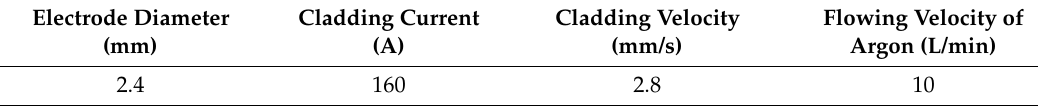
Figure 4. Schematic diagram of the wear experiment.